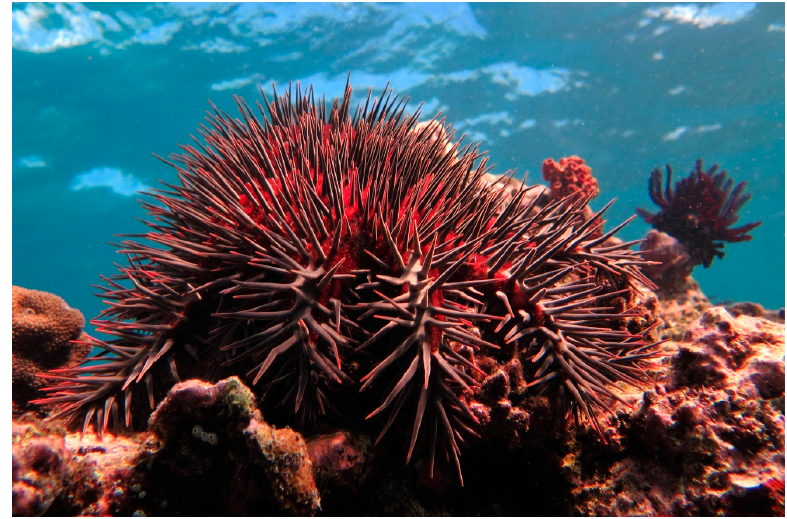
Figure 1. Adult crown-of-thorns starfish are defended against predators by numerous long, very sharp and toxic spines. Photographic credit: Scott Ling, Dick’s Reef, Swains Region, southern Great Barrier Reef (22°18 ′ S, 152°39 ′ E).